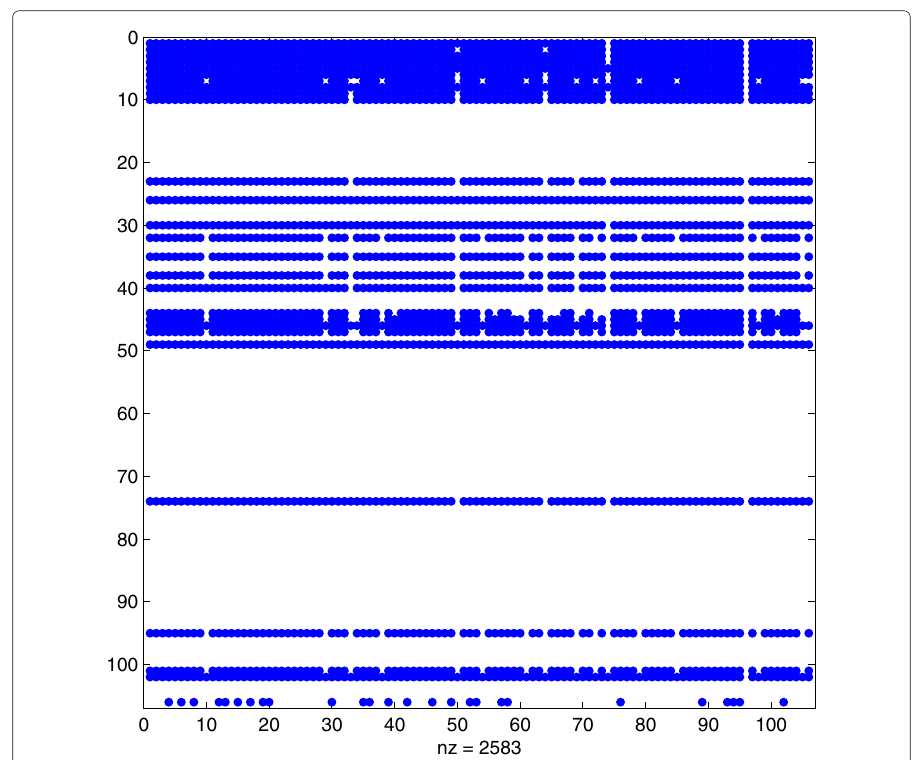
Fig. 8 Sparsity pattern. Real: sparsity pattern of the final matrix (cid:12) Q [ M ] computed using (4) with α =